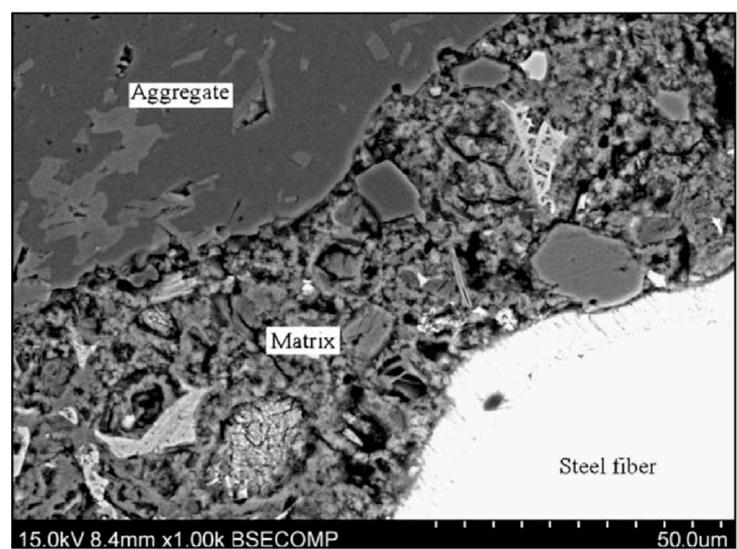
Figure 4. Transverse cross-section of the interfacial zone in the matrix (ITZ) between fibre and ma- trix [49].